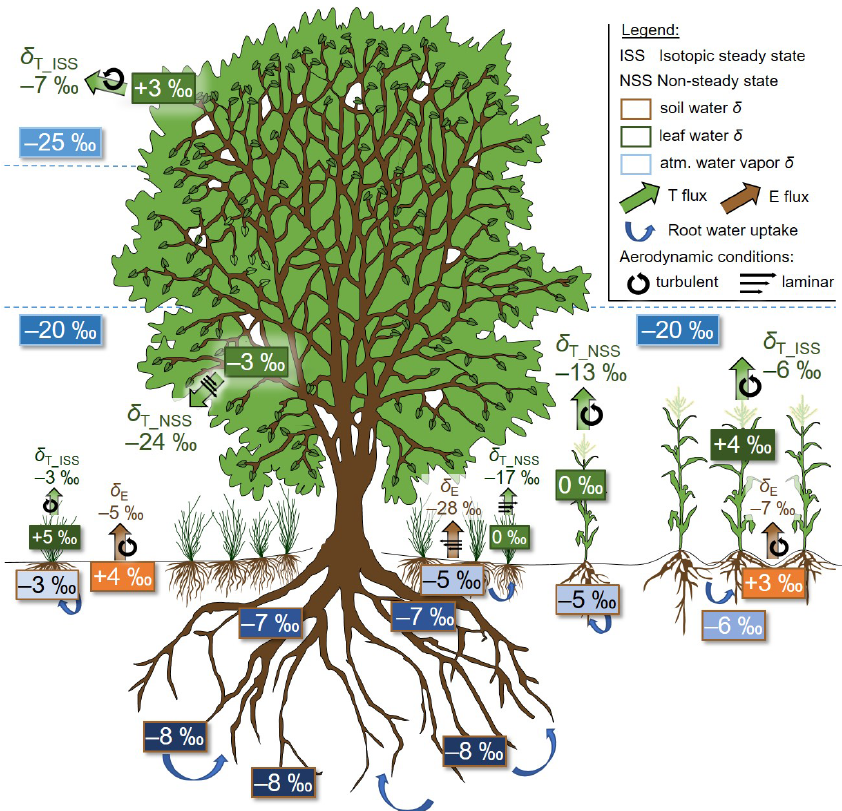
Figure 1. Conceptual drawing reporting the sources of differences in (synthetic) values between the (exemplary oxygen) isotopic composi- tions of evaporation ( δ E , ‰) and transpiration ( δ E , ‰) in an agroforestry context, namely (i) the type of vegetation and root development (tree vs. maize crop vs. grass layer); (ii) the prevalence of isotopic-steady-state (ISS) or non-steady-state (NSS) conditions for leaf water; and (iii) the environmental conditions acting on fluxes, i.e. soil water and atmospheric water vapour isotopic composition profiles, and leaf water isotopic composition (values displayed in boxes outlined in brown, blue, and green). δ E and NSS δ E values were calculated with the Craig and Gordon (1965) model assuming laminar-flow conditions (designated by the three superimposed arrows) under the pictured tree and within its canopy and fully turbulent conditions (designated by a circular arrow) elsewhere (e.g. at the top of the tree canopy, above the maize crop for δ E , and in its interrow space for δ E